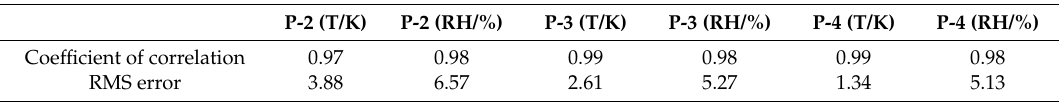
Table 2. Root mean square (RMS) error and coefficient of correlation compared to the measured temperature and relative